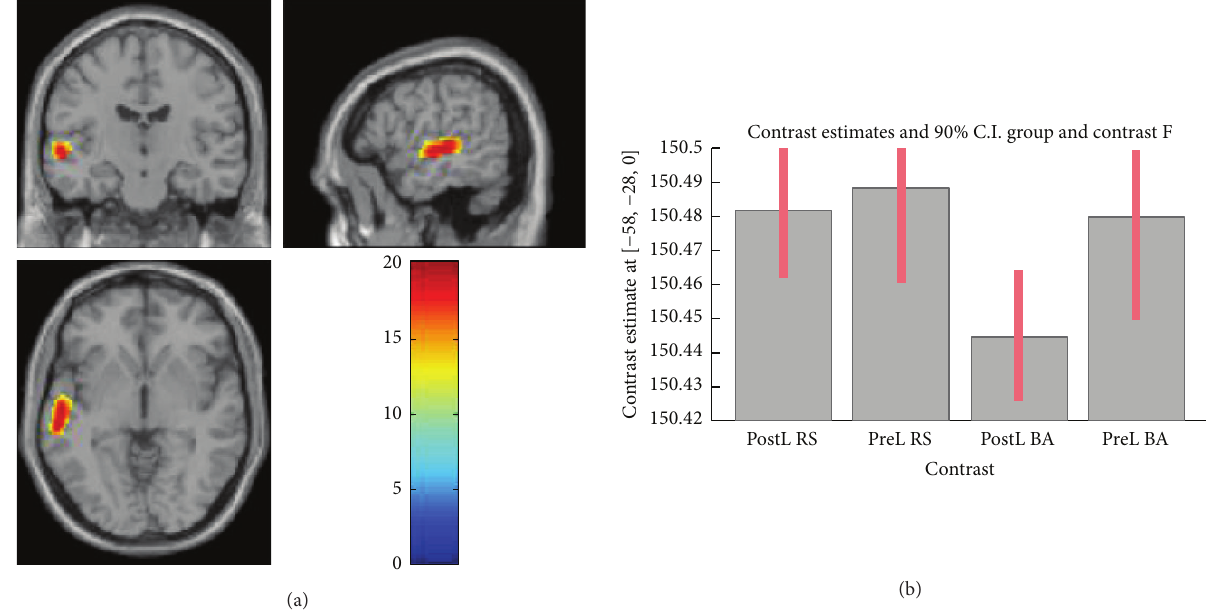
Figure 2: (a) Activation map for interaction between effect of contrast and effect of PRE/POST subgroup in the ROI analysis (L BA 21/22) showing greater activation during speech for the postlingual group. (b) Contrast estimates of conditions in the two subgroups showing a larger difference in the postlingual subgroup than in the prelingual subgroup. PostL: postlingual group; PreL: prelingual group; RS: running speech condition; BA: multitalker babble condition.